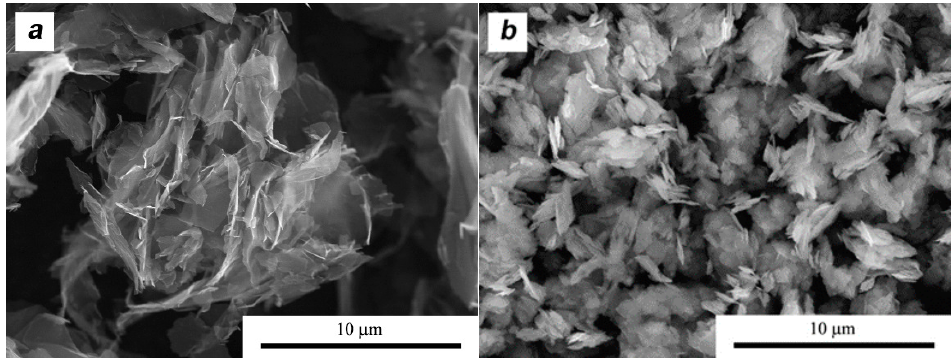
Figure 2. Morphology of: ( a ) multilayer graphene MLG and ( b ) MoS 2 powders.